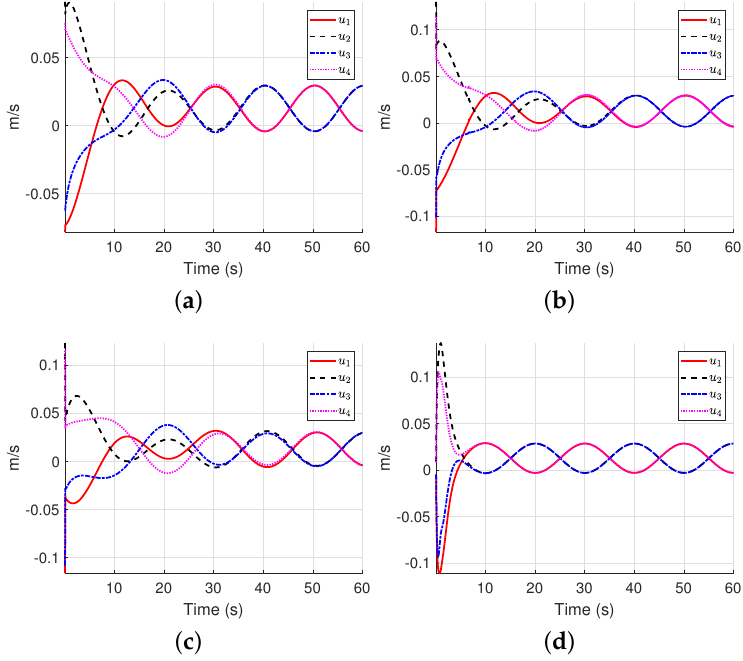
Figure 10. Velocity control signal results for the sinusoidal trajectory. ( a ) Velocity control signal of PID. ( b ) Velocity control signal of BP-PIDNN. ( c ) Velocity control signal of HR-PIDNN. ( d ) Velocity control signal of